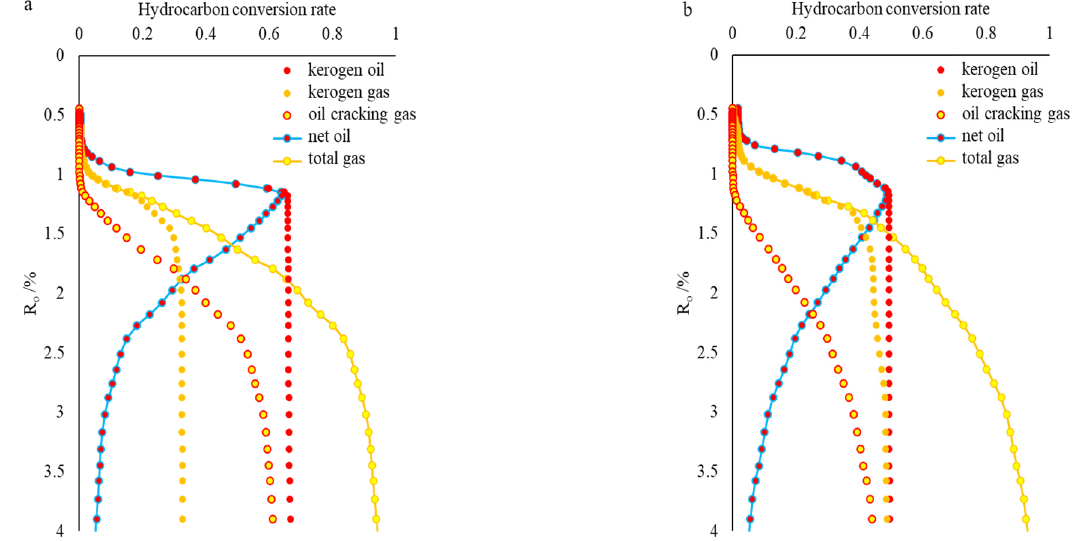
Figure 11. Conversion rate profiles of different types of organic matter into hydrocarbons (( a ). type II 1 ; ( b ). type II 2 ).